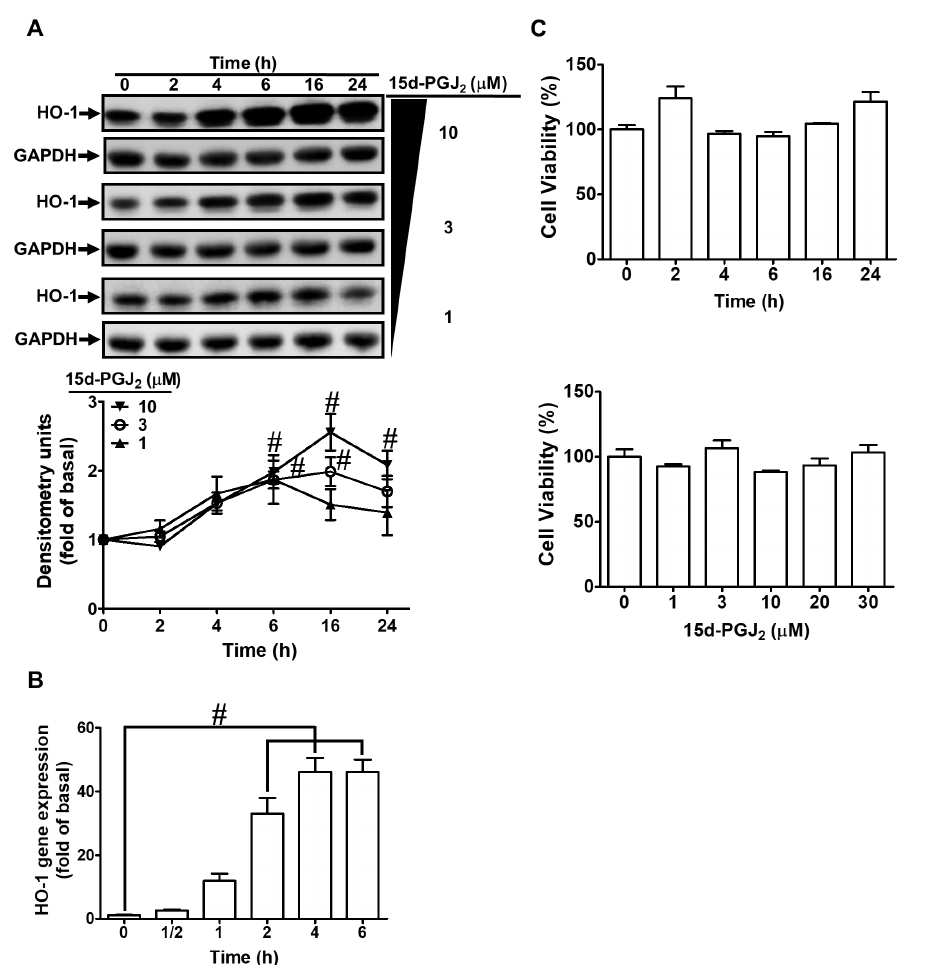
Figure 1. 15d-PGJ 2 induces gene and protein expression of HO-1 in bEnd.3 cells. ( A ) The cells were incubated with 15d-PGJ 2 (1, 3, 10 μM) for 0, 2, 4, 6, 16, and 24 h. The cell lysates were examined by Western blotting using the polyclonal antibody of HO-1 or GADPH (serving as a loading control). ( B ) The cells were stimulated with 10 μM 15d-PGJ 2 for 0.5, 1, 2, 4, and 6 h. The HO-1 gene expression was analyzed by real-time PCR. ( C ) The cells were incubated with 10 μM of 15d-PGJ 2 for 2, 4, 6, 16, and 24 h (upper panel) and with various doses (1, 3, 10, 20, and 30 μM; lower panel) for 24 h, and then cell viability was analyzed by an XTT assay. Data are expressed as the mean ± S.E.M. of three independent experiments. # p < 0.01, as compared with the vehicle alone or basal level. Abbrevia-